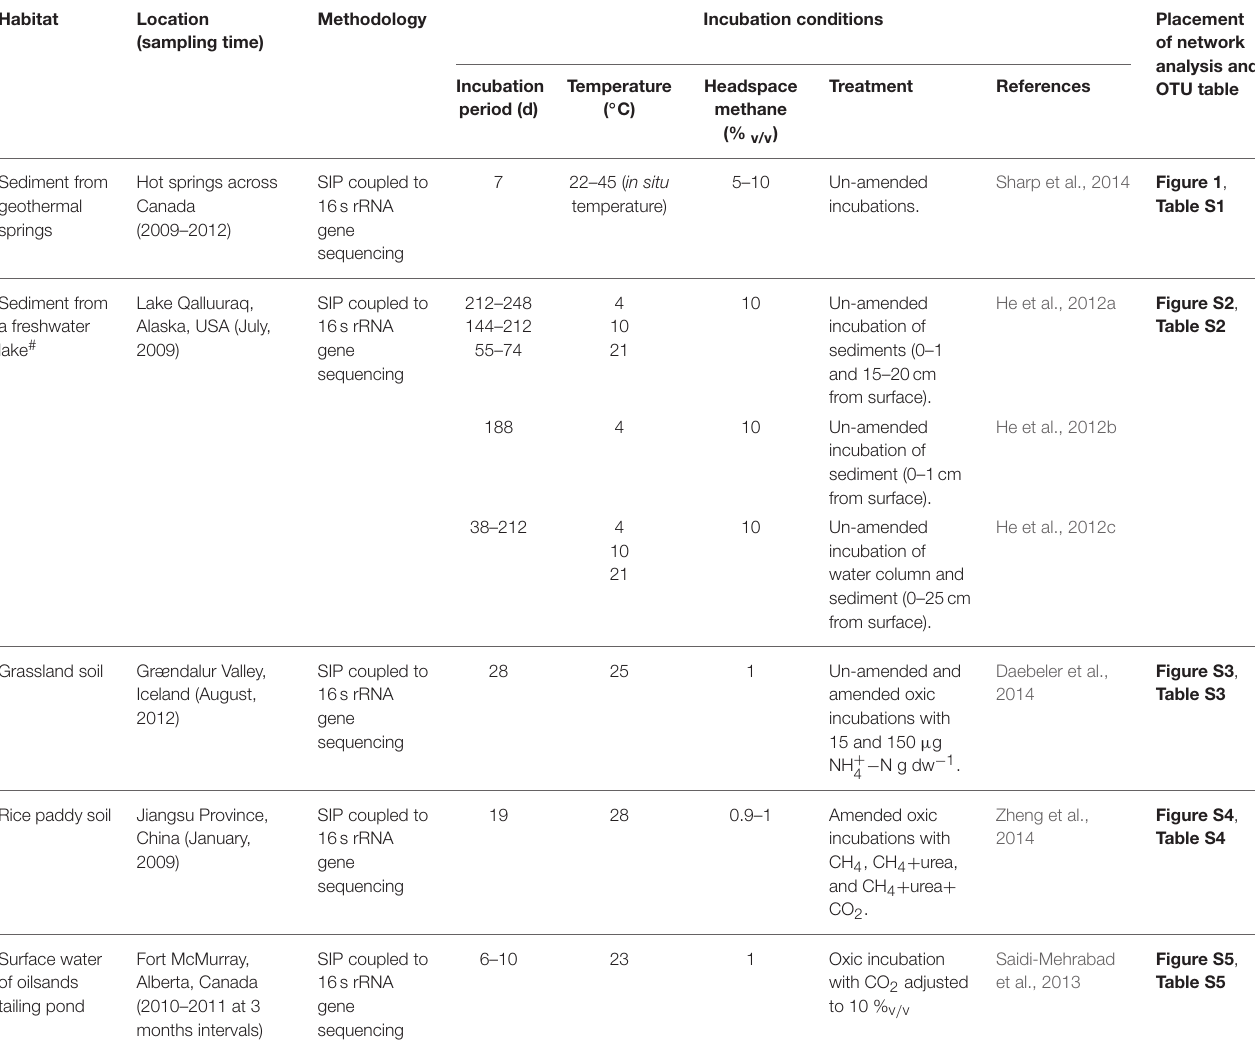
TABLE 1 | Studies considered for the network analysis, including site information and incubation/experimental conditions.